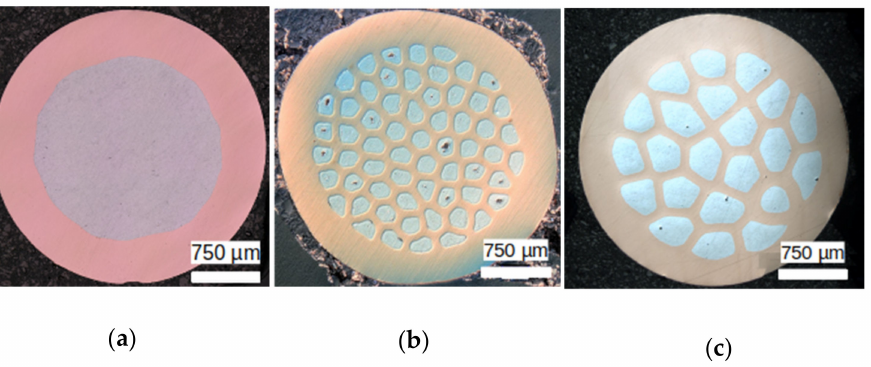
Figure 1. Illustration of the cross-section of the the different 3 mm diameter wires considered in this study: ( a ) conventional CCA; ( b ) architectured wire with 61 aluminum fibers and ( c ) architectured wire with 22 aluminum